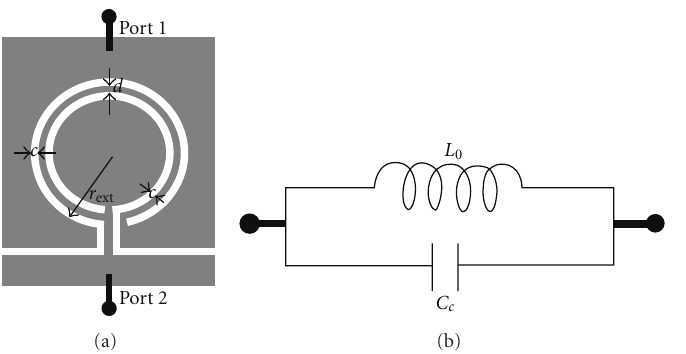
Figure 1: Typical topology of the OCSRR (a) and equivalent circuit model (b). The two terminals—ports—of the open resonator are